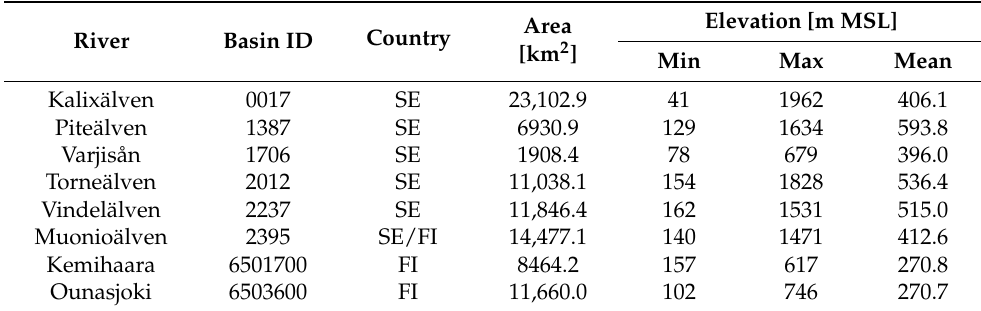
Table 1. Catchment properties of the eight selected sub basins. The Basin ID is the official number of the catchment area according to SMHI (Sweden) and SYKE (Finland).